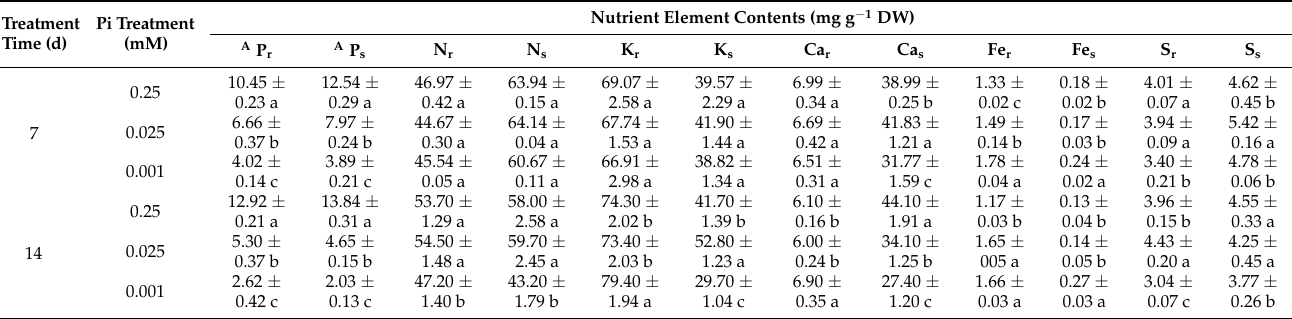
Table 2. Nutrient element contents in the roots and shoots of melon seedlings grown under low-Pi stress. The values are presented as the mean ± SD ( n = 3). The lowercase letters indicate significant differences in the parameter, at the same treatment time, among the treatments using one-way ANOVA with Tukey’s test ( p < 0.05). P r , N r , K r , Car, Fe r , and S r : P, N, K, Ca, Fe, and S content in the root, respectively. P s , N s , K s , Ca s , Fe s , and S s : P, N, K, Ca, Fe, and S content in the shoot, respectively. A The data of P r and P s at 14 d are published in [39].